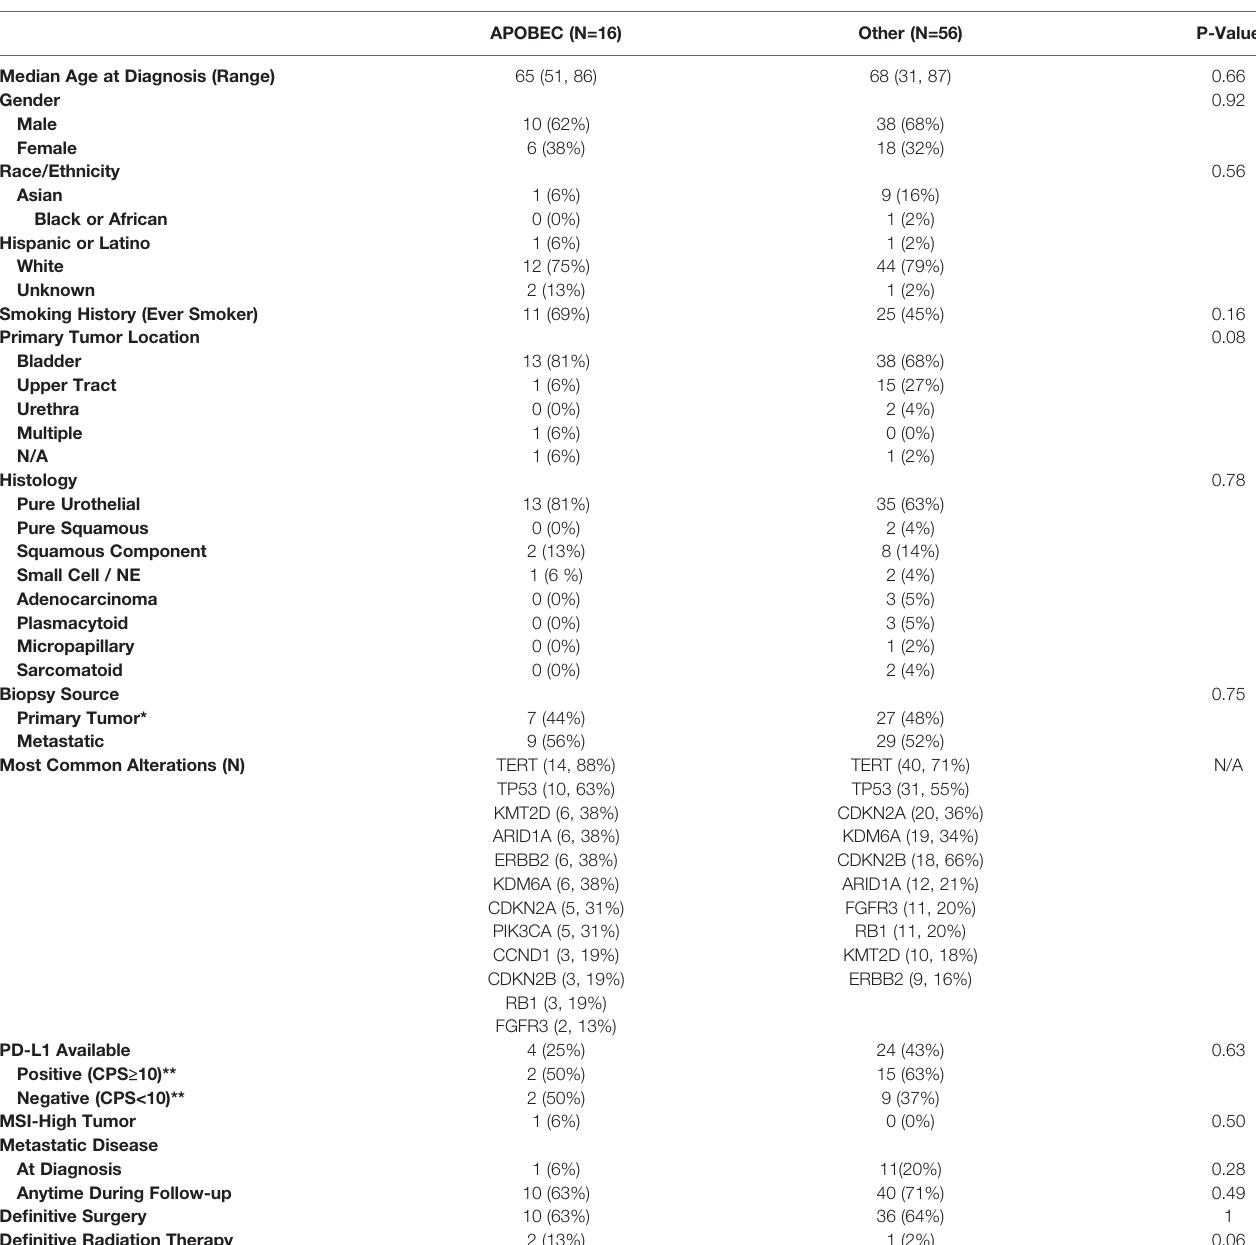
TABLE 2 | Clinical characteristics of patients in the APOBEC and Other groups. APOBEC